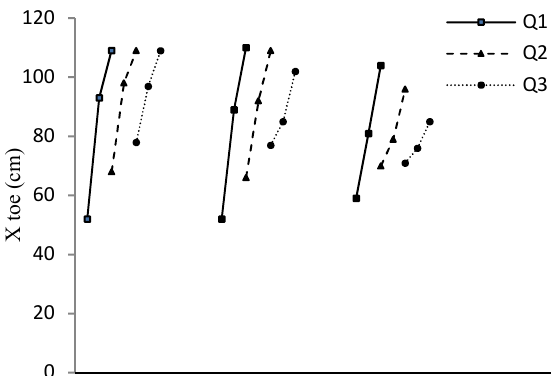
Fig. 7: Comparing the combined effects of the factors on the toe position at final steady state condition